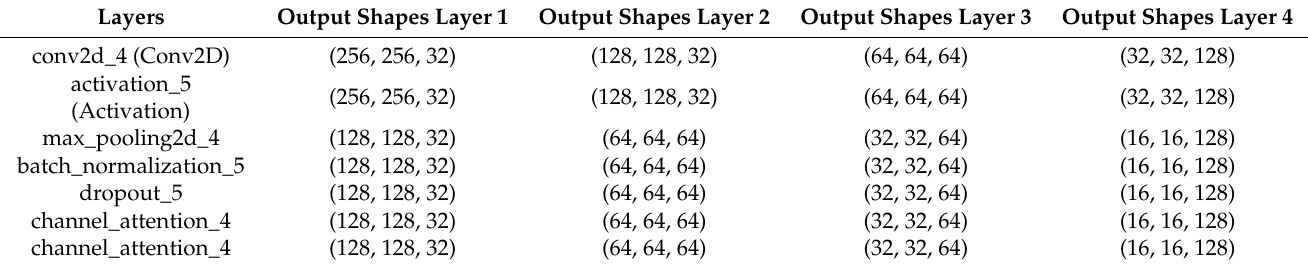
Table 1. Hyper Parameter used in proposed